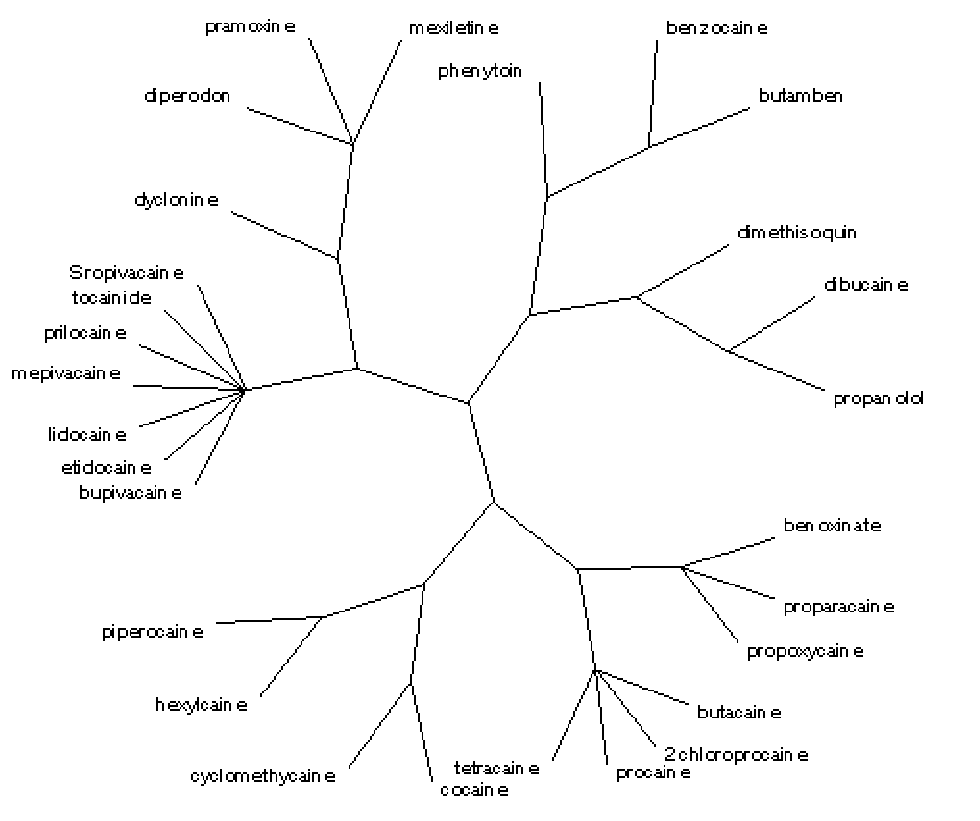
Figure 5. Radial tree for the local anaesthetics analogues of procaine from 1 to 11 classes. The resulting partition into classes compares well with other from Covino considered as good [8]. He compared three ester, viz . 2-chloroprocaine, procaine, and tetracaine, as well as five amide local anaesthetics, viz . bupivacaine, etidocaine, lidocaine, mepivacaine, and prilocaine, based on